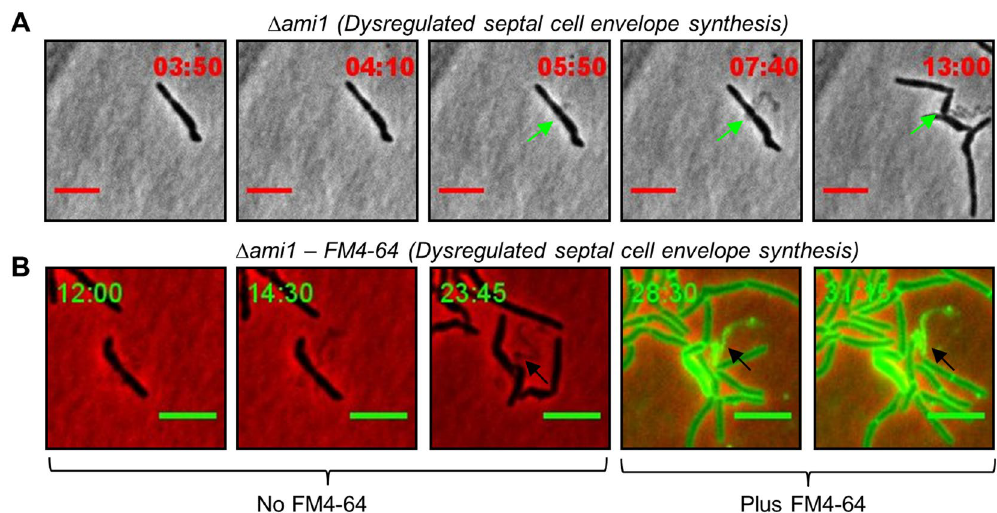
Figure 6. ( A ) Time-lapse microscopic analysis of septal cell wall release in the Δ ami1 mutant strain. Cells were grown and imaged in Middlebrook 7H9 media. ( A ) Shown is the growth of the Δ ami1 strain with release of material from the septum (green arrow) suggestive of dysregulated septal envelope synthesis. ( B ) Depicts growth of the Δ ami1 strain in the presence of FM4-64 (last two frames), the black arrows highlight positive FM4-64 staining of the cell envelope material released from mid-cell. Scale = 5 µ m. Time frame is in